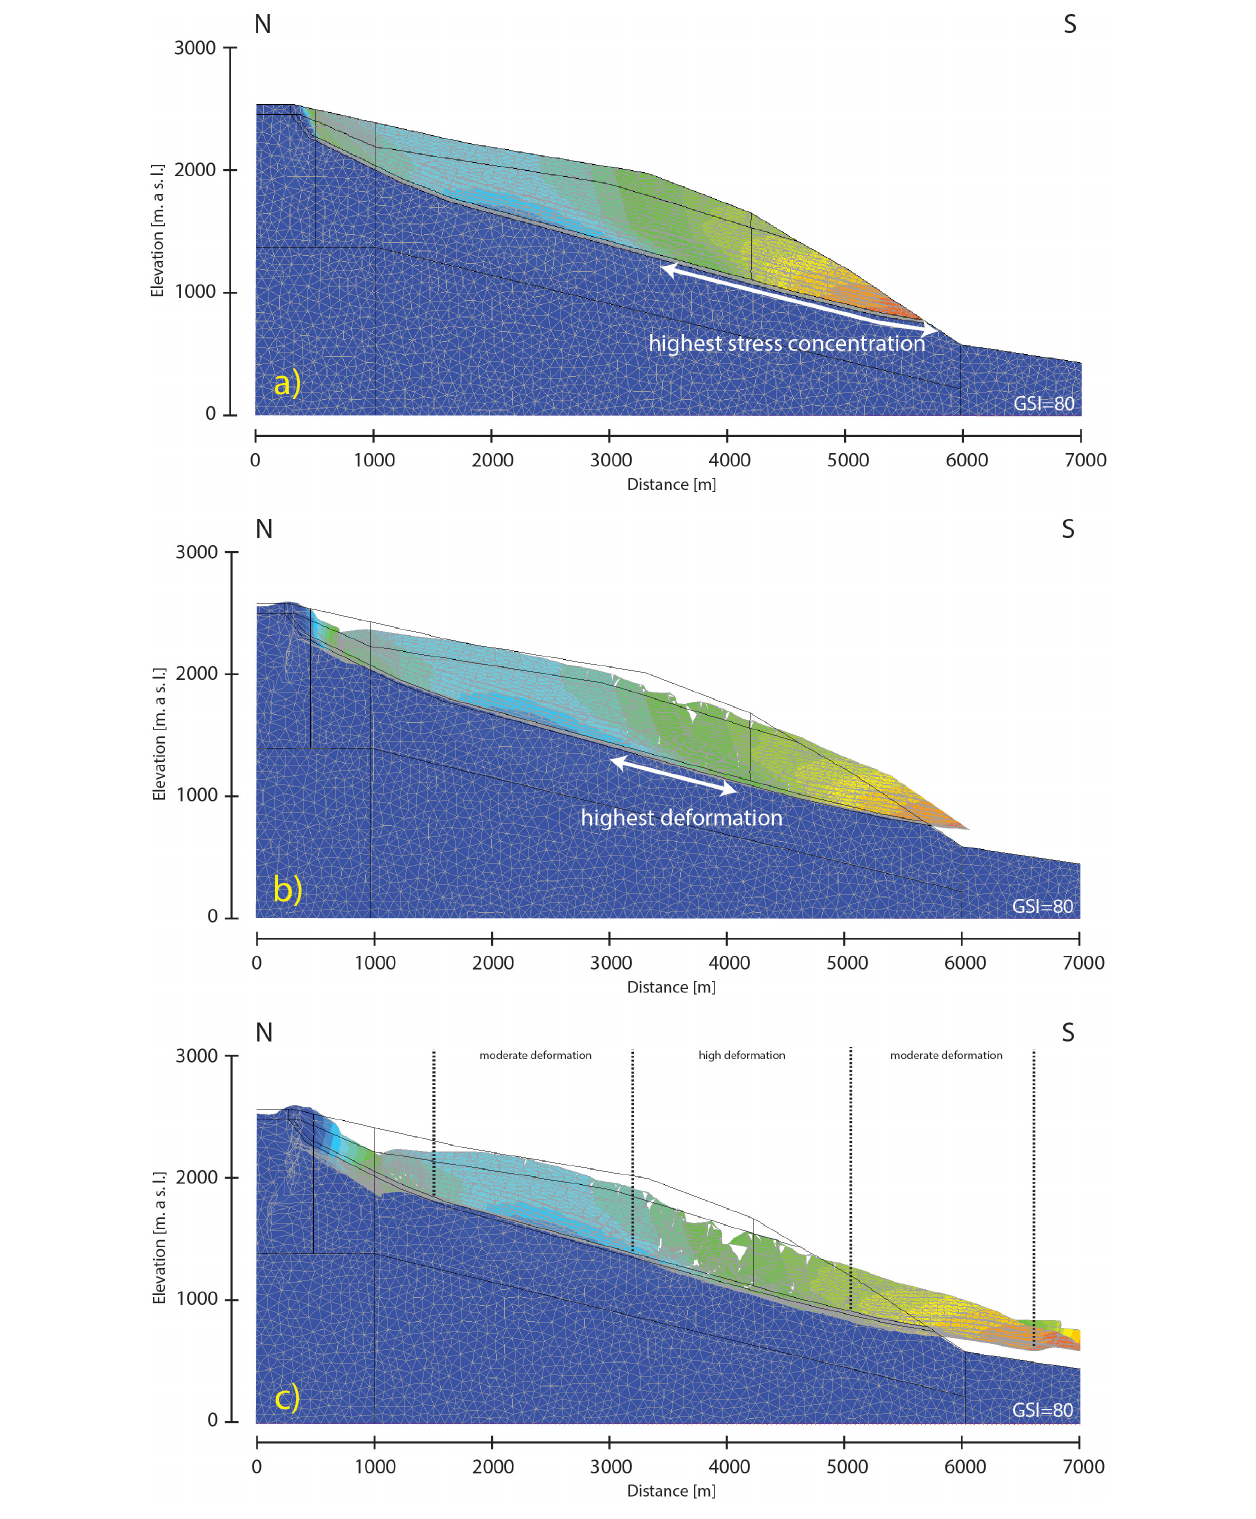
FIGURE 12 | Results of the fracture network model. (a) Displacement contours indicate highest movement between 3500 and 6000 m distance, where displacement increases toward the slope toe. (b) The headscarp and the middle part of the rockslide mass are subjected to extensional processes and sliding mass is separated into three compartments. (c) The rockslide body can be separated into higher (middle part) and lower (upper and lower parts) deformation regions.